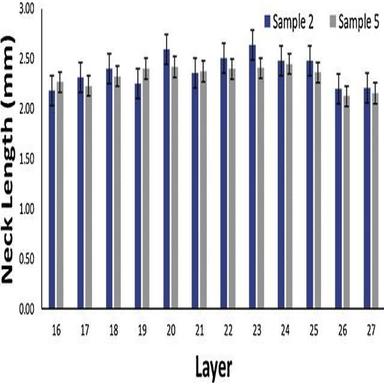
Variation of neck sizes between specimens 2 and 5.